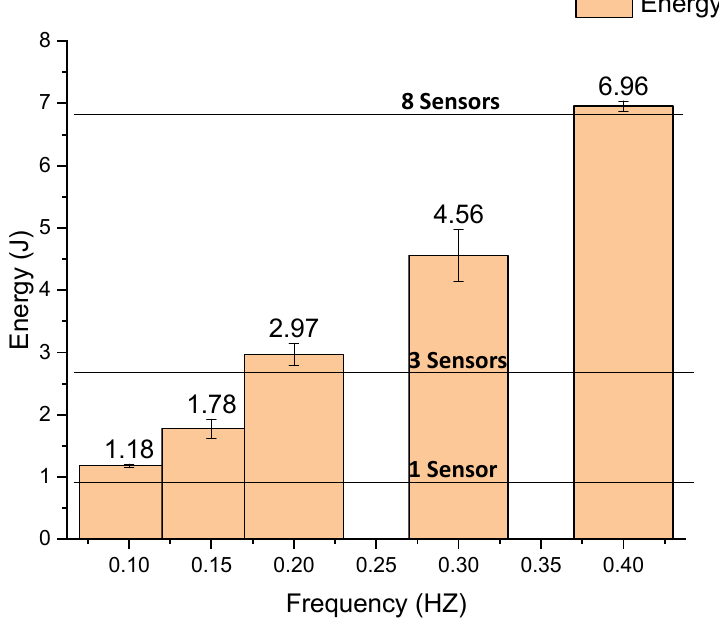
Figure 14. Capacitor voltage during a 900 s charge, with several movement frequencies. Considering the time ‐ voltage graph of Figure 15, the stored energy in the capacitor can be calculated by Equation (9). The graph of Figure 15 shows the energy storage in the capacitor for 900 s.